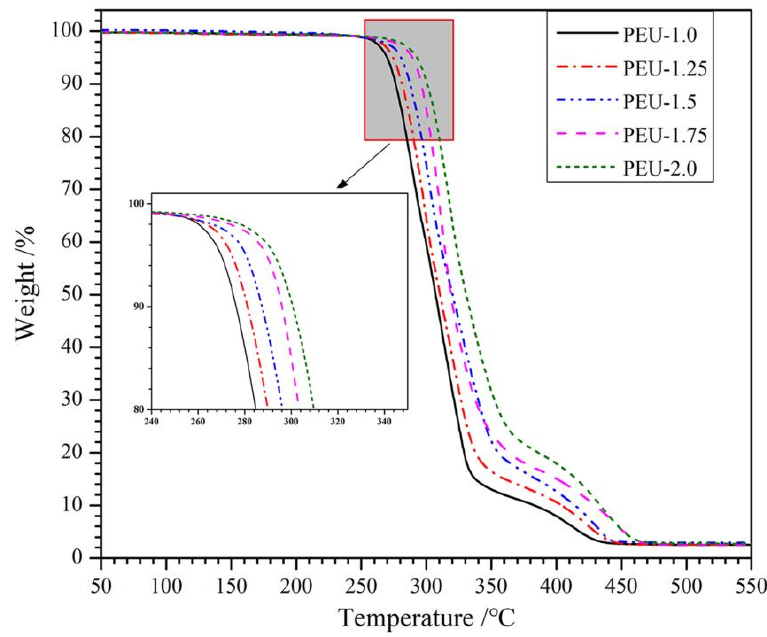
Figure 4. TGA curves for PEU films.